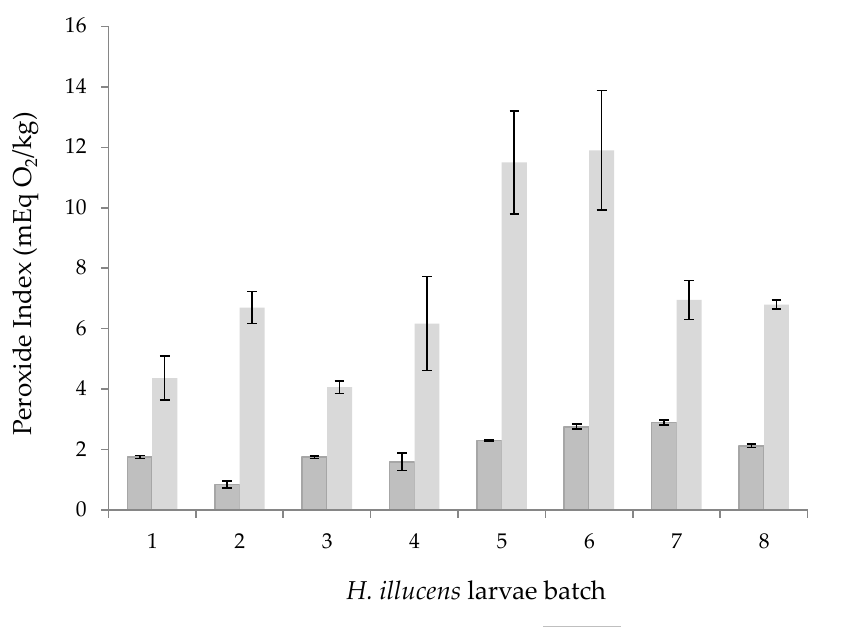
Figure 7. Peroxide Index of the oils extracted by SFE ( ) and the oils extracted using hex- ane ( ).